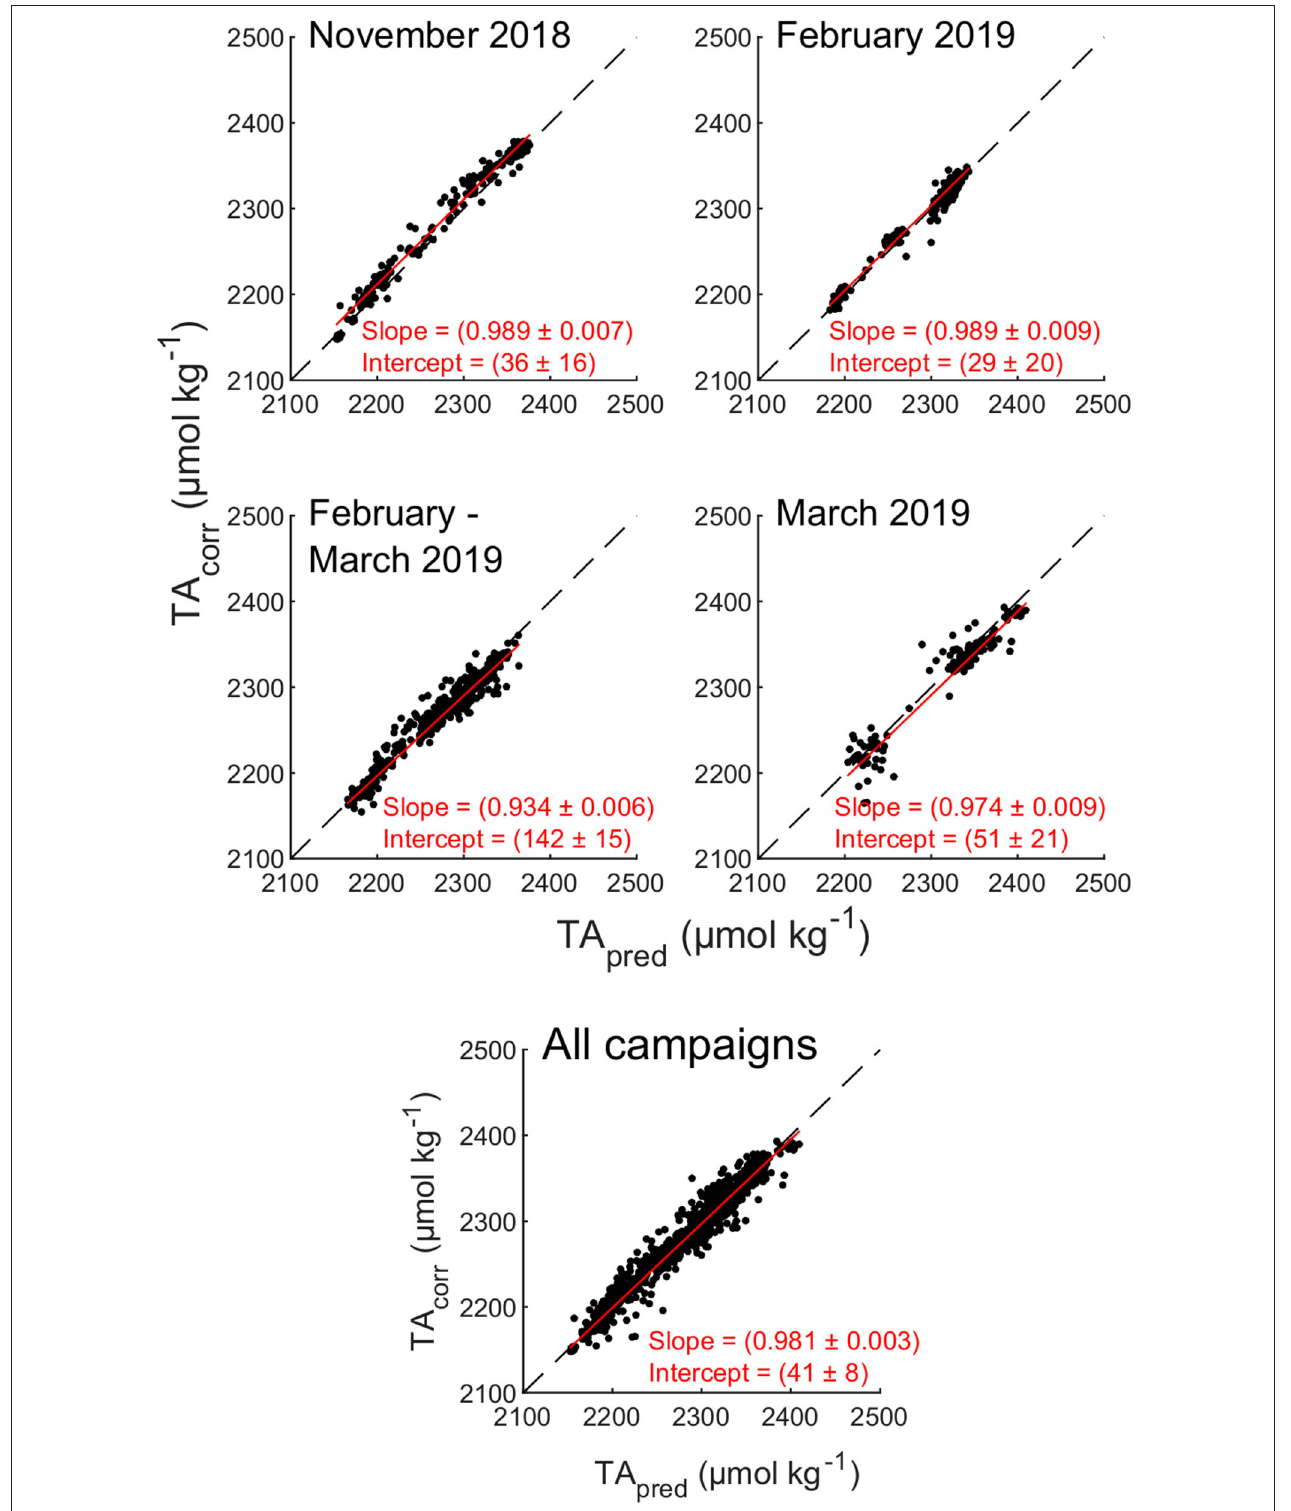
FIGURE 8 | TA values (after drift correction) measured by the analyzer (TA corr ) as a function of the predicted TA values (TA pred ) using the established parameterization described by Lee et al. (2006) for each measuring campaign, and for all campaigns together. The black dashed lines indicate the 1-to-1 line of the plot. The red solid lines represent the linear correlation between TA corr and TA pred with their slopes and intercepts given in each plot.